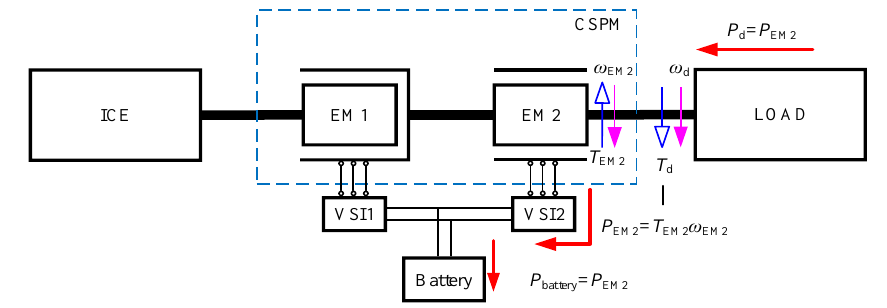
Figure 7. Regenerative braking mode and the related power flow diagram.